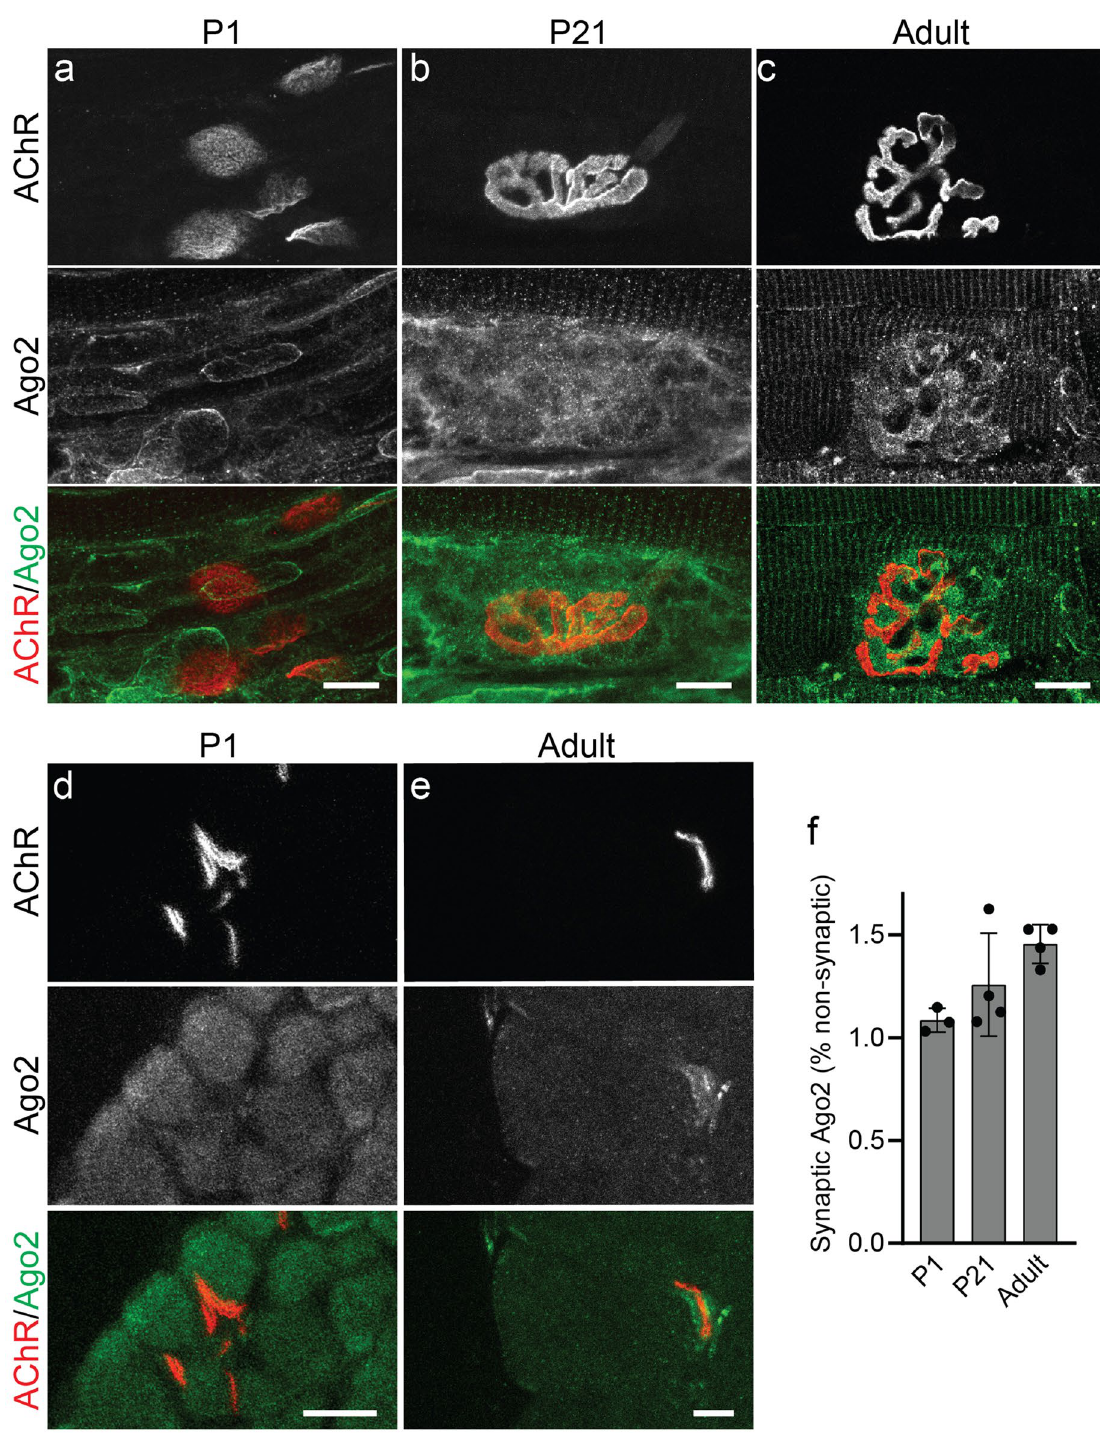
Figure 2. Ago2 distribution is concentrated at the NMJ in adult EDL muscle. ( a – c ) Representative images of Ago2 IHC (green) and fBTX labeled AChRs (red) in P1 ( a ), P21 ( b ) and Adult ( c ) EDL. ( d , e ) Representative images of Ago2 IHC (green) and fBTX labeled AChRs (red) in P1 ( d ) and Adult ( e ) TA cross-sections. ( f ) Quantification of synaptic Ago2 pixel intensity, relative to non-synaptic Ago2 pixel intensity, in TA muscle cross sections. *p < 0.05, unpaired 2-sided t test. All values reported as mean ± SD; n = 3–4. All scale bars = 10